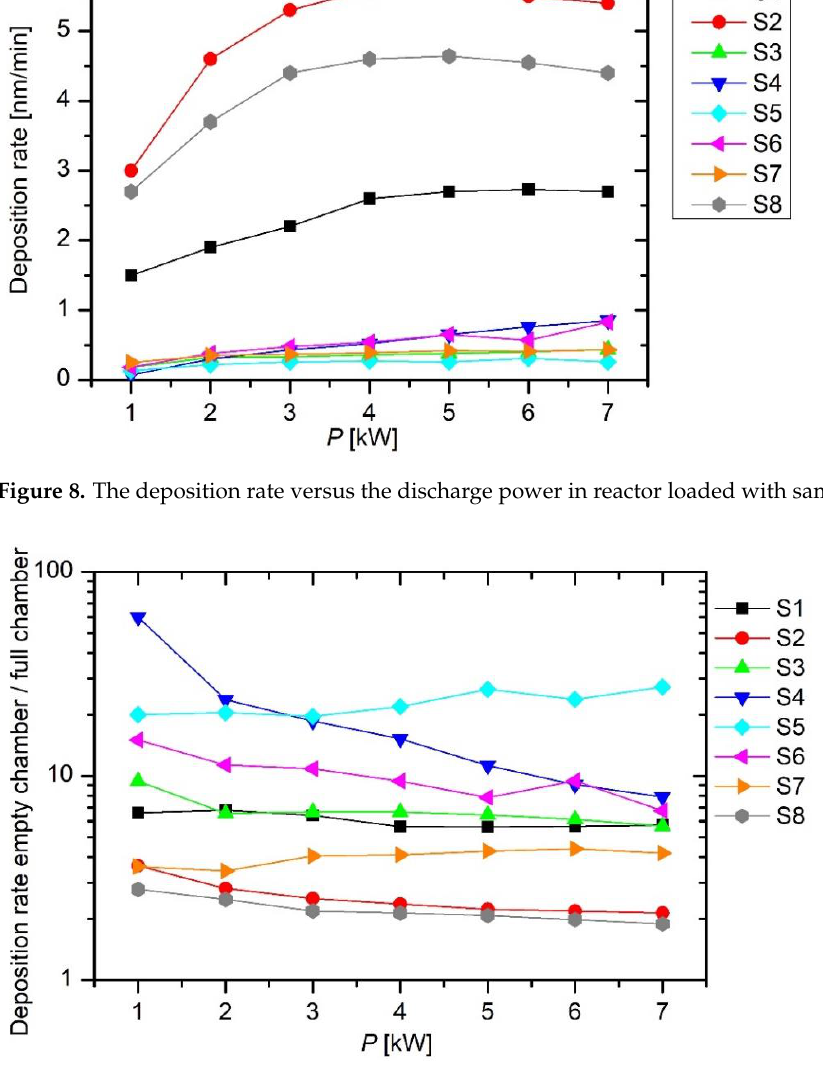
Figure 9. The deposition rate versus the discharge power in reactor loaded with samples.